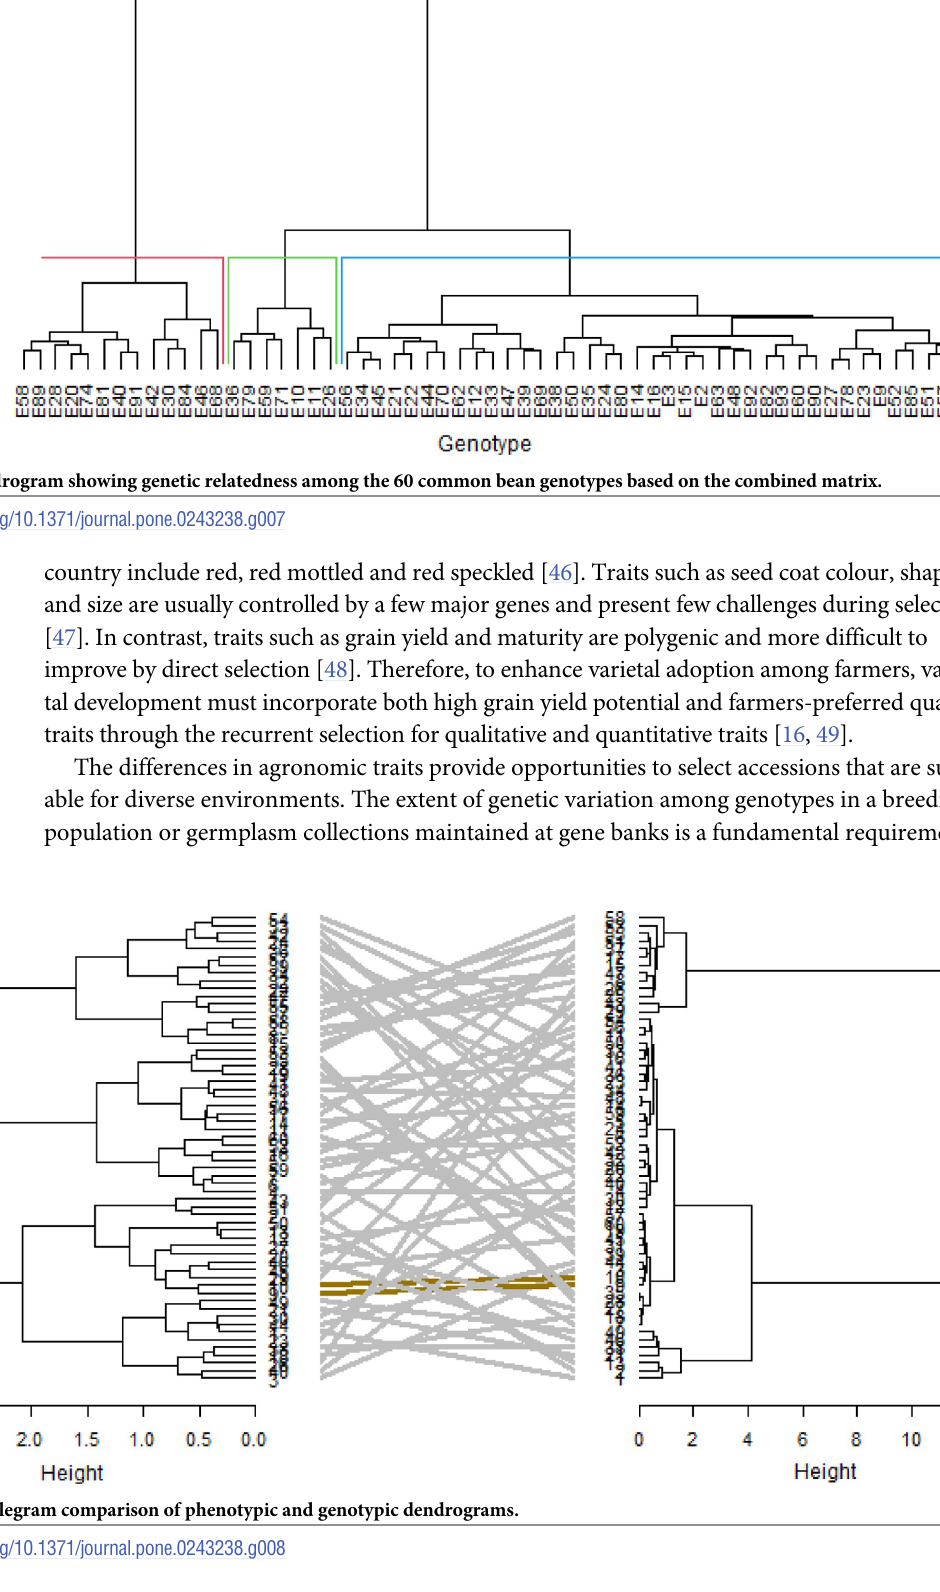
PLOS ONE | https://doi.org/10.1371/journal.pone.0243238 December18,